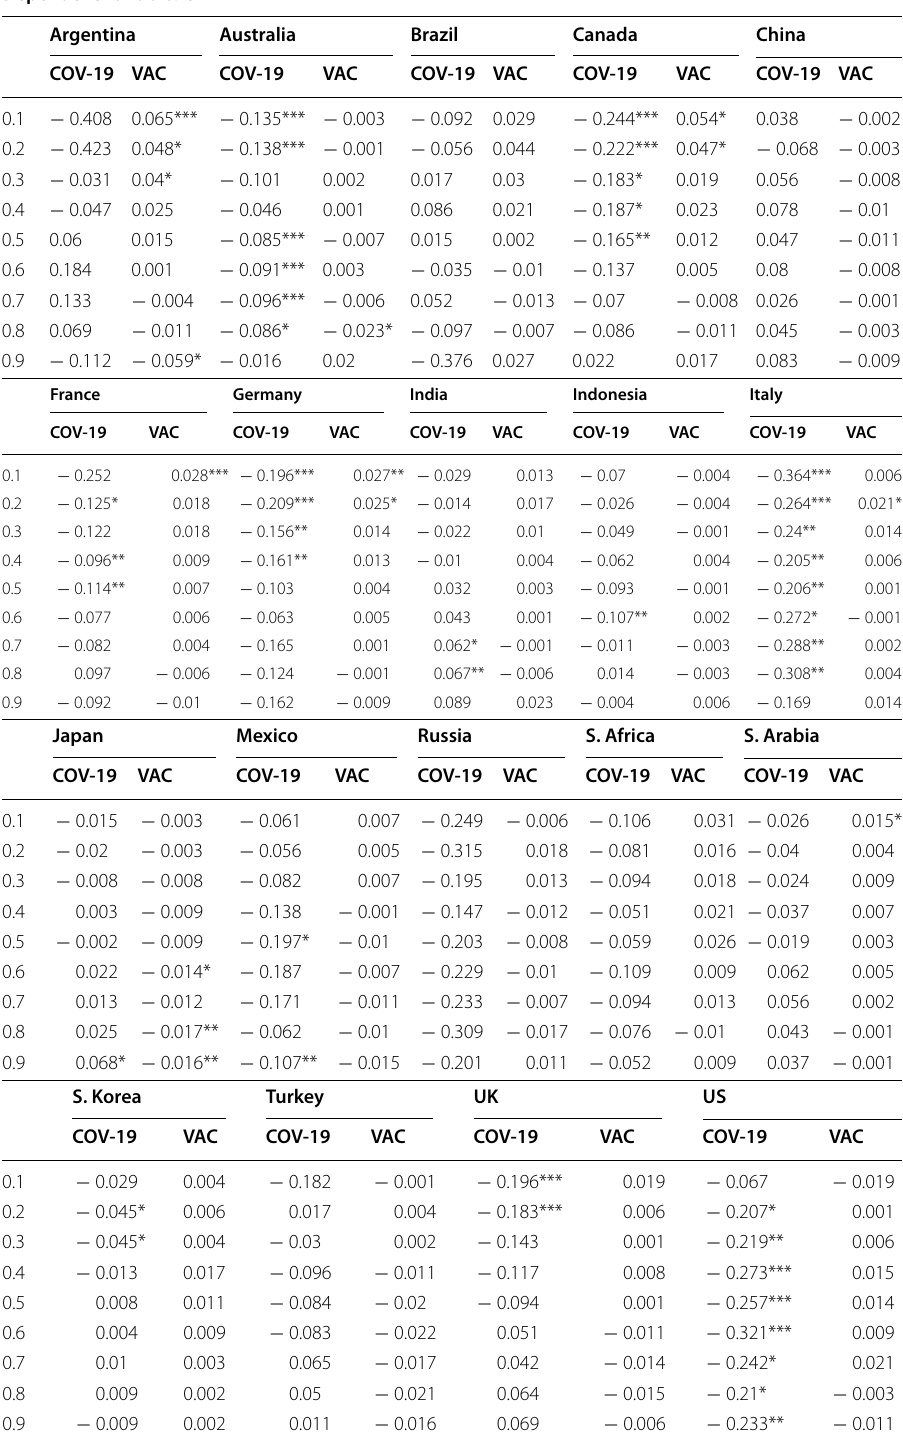
Table 10 Country quantile regression results for stock returns Dependent variable: